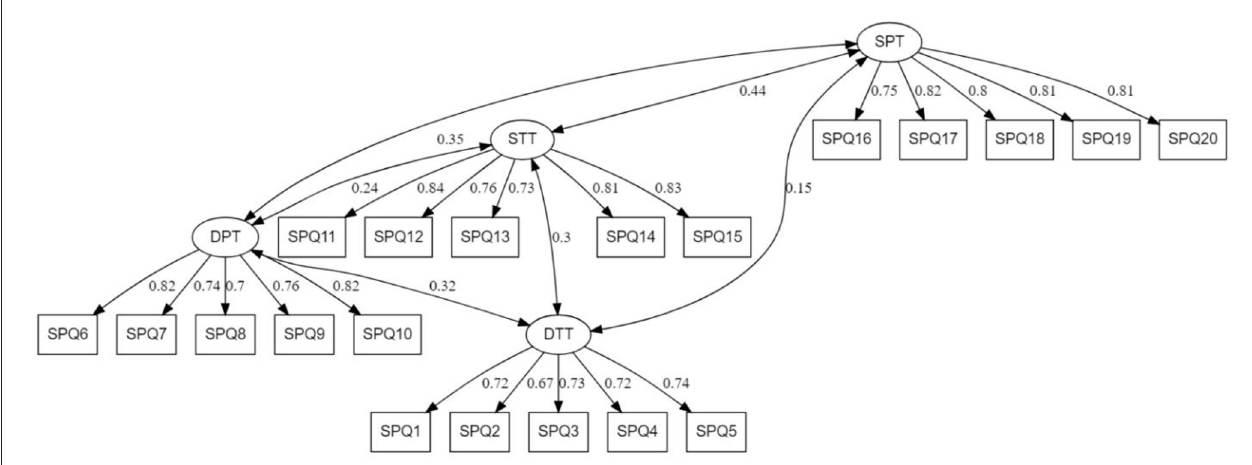
FIGURE 2 | Confirmatory factor analysis of the PE-SPQ. χ 2 = 466.47, df = 164, p < 0.001, χ 2/df = 2.84, GFI = 0.92, AGFI = 0.90, TLI = 0.94, CFI = 0.95, SRMR = 0.046; RMSEA = 0.56 IC 90% [0.050–0.062]; DPT, Deep Practical Task; DTT, Deep Theoretical Task; SPT, Surface Practical Task; STT, Surface Theoretical Task.